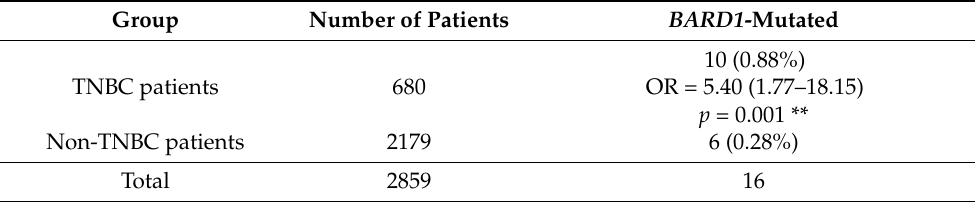
Figure 1. Spectrum of BARD1 germline pathogenic variants found in our cohort. Locations of variants are displayed by lollipop structures with the following color code: orange for nonsense variants, yellow for frameshift variants and green for splicing variants. Horizontal lines correspond to copy number variants, each found in one index case. The different BARD1 protein domains are shown in dark blue boxes with an amino acid numbered scale. Table 3. Summary of the triple-negative status of the hereditary breast cancer